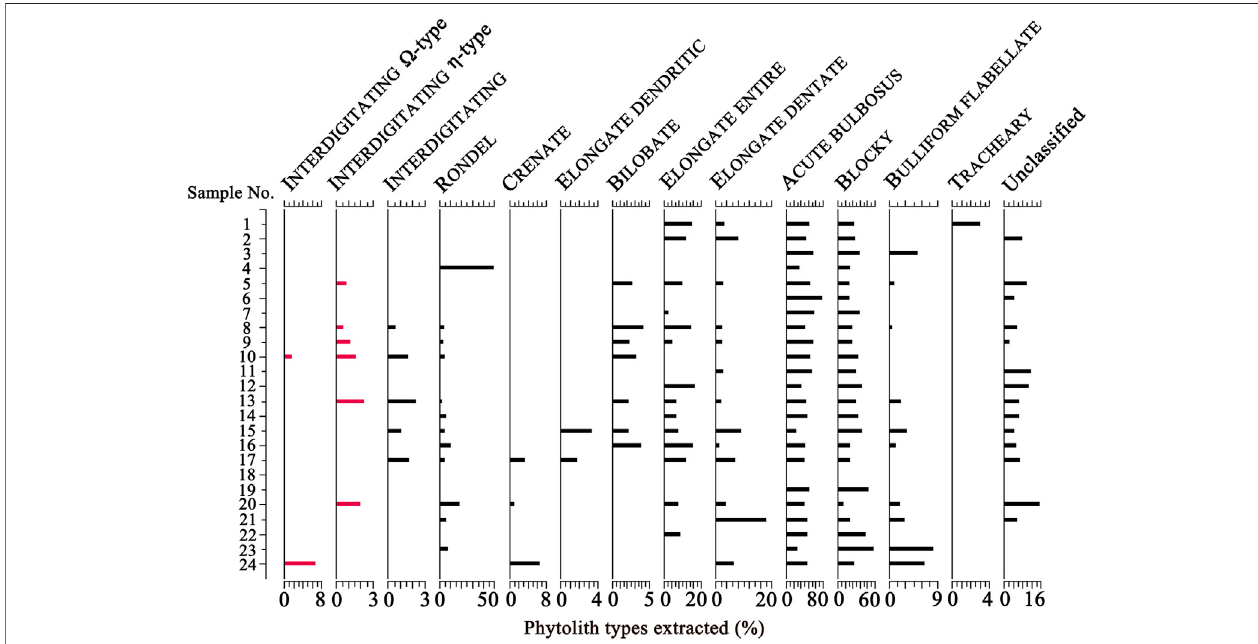
FIGURE 6 | Changes in percentages of phytolith types extracted from the 24 human dental calculus at the Lajia site.